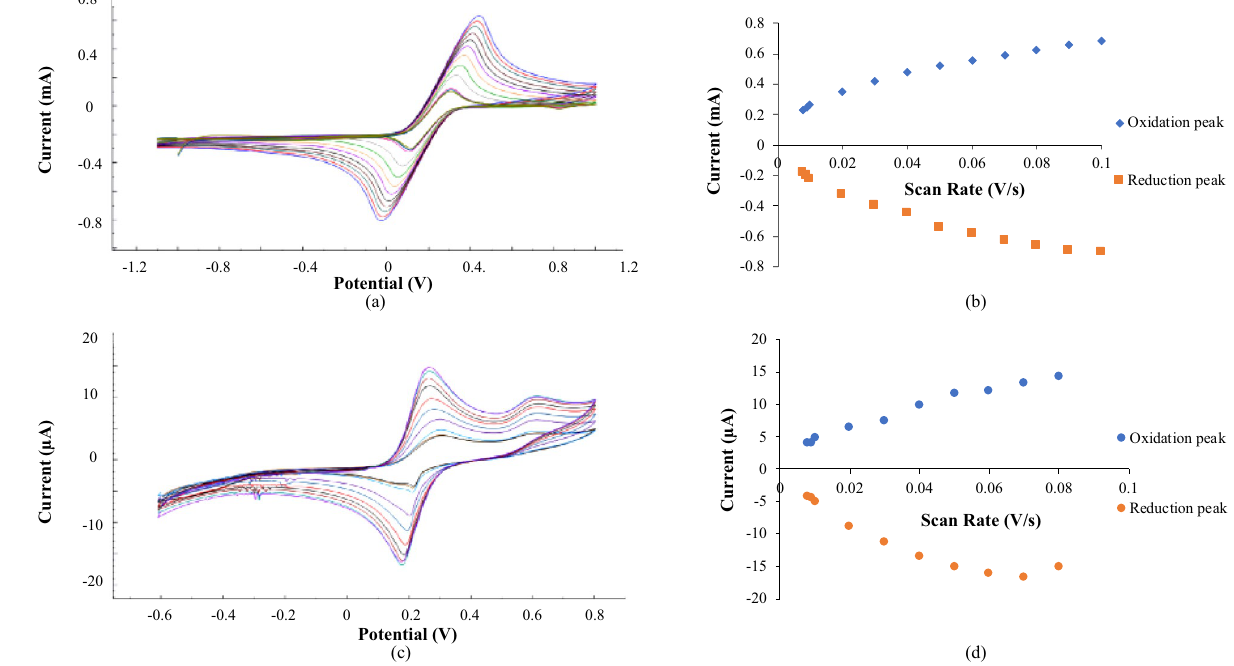
Figure 9. ( a ) scan rate study of DNA biosensor in K 3 Fe(CN) 6 ; ( b ) cyclic voltammetry plot at different scan rate in K